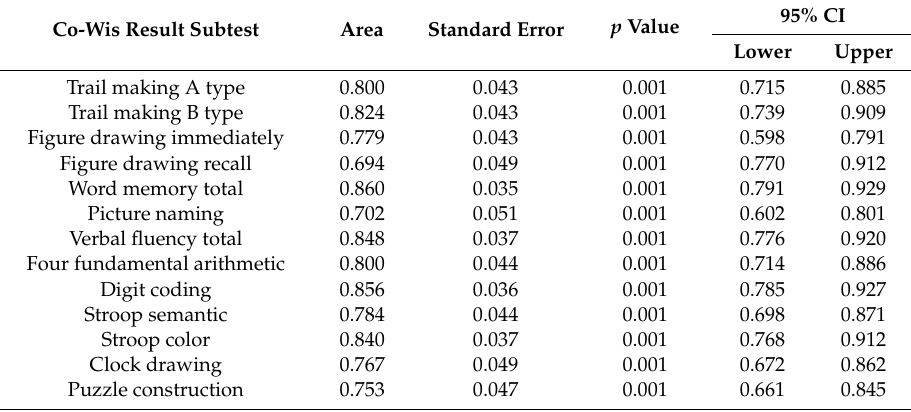
Figure 7. Receiver operating characteristic of computer-based dementia assessment contents (Co-Wis). ( a ) Positive ROC curve (trail making), ( b ) negative ROC curve (figure drawing, word memory, picture naming, verbal fluency, four fundamental arithmetic, digit coding, stroop, clock drawing, puzzle construction). Table 8. Receive operating characteristic curve of Co-Wis.